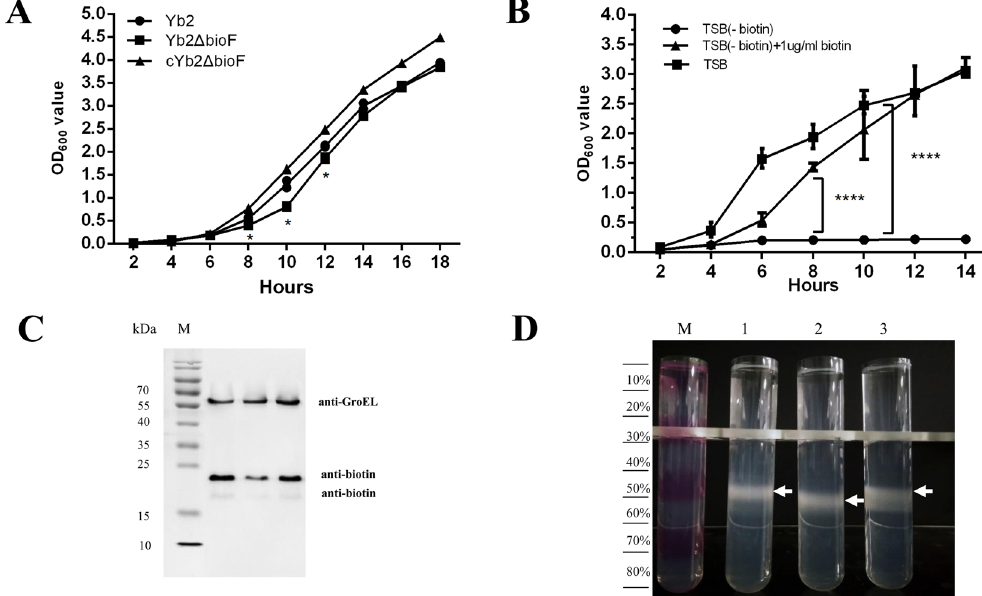
Figure 2. Characterization of mutant strain Yb2 Δ bioF. ( A ) Growth curves of Yb2, Yb2 Δ bioF and cYb2 Δ bioF in tryptic soy broth (TSB). ( B ) Growth curves of Yb2 Δ bioF in TSB, TSB-biotin and TSB-biotin + biotin. Each point represents the mean ± standard for triplicate samples. ( * p < 0.05; *** p < 0.001). ( C ) Immunoblot analysis of the biotinylated protein. Whole-cell proteins of each strain were separated on sodium dodecyl sulfate polyacrylamide gel electrophoresis (SDS-PAGE) gel, transferred to nitrocellulose membrane, blotted with streptavidin peroxidase, and visualized by chemiluminescence. Riemerella anatipestifer GroEL was used as a protein loading control. The full-length blots are presented in Supplementary Figure S3. ( D ) Percoll density gradient centrifugation of the R. anatipestifer strains. The gradient is visualized using fuchsine-stained layers in the marker (M). Lane 1, the wild-type strain Yb2; lane 2, the mutant strain Yb2 Δ bioF; lane 3, the complemented strain cYb2 Δ bioF.